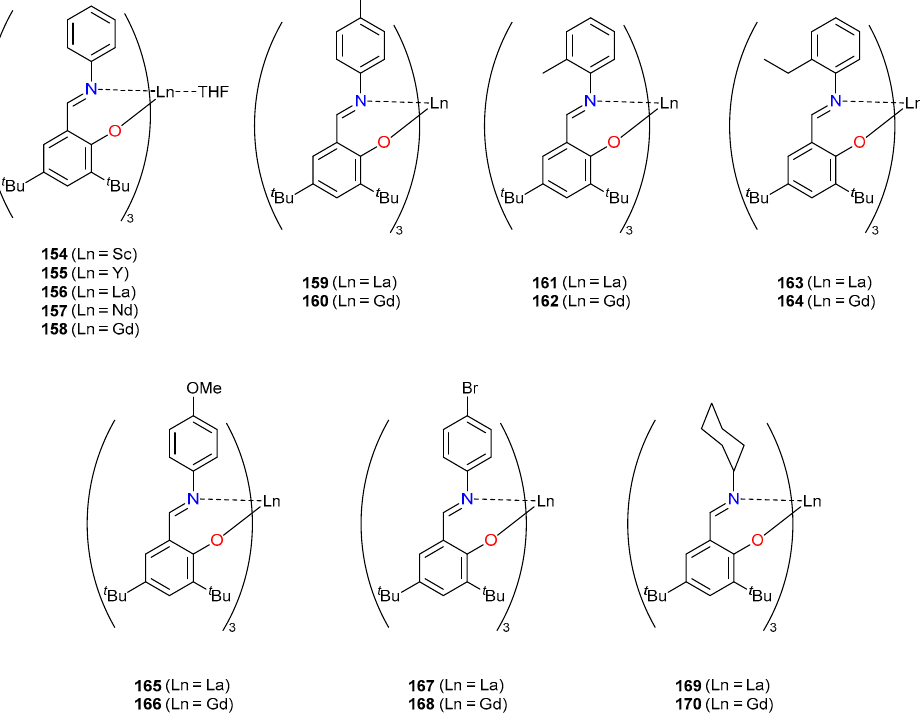
Figure 29. Rare-earth metal complexes bearing phenoxyimine ligands [87,89].